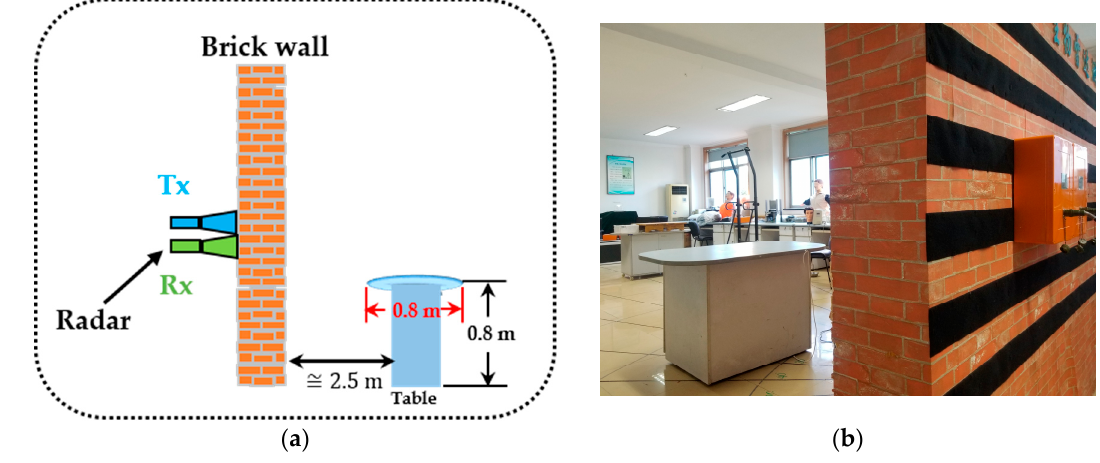
Figure 13. Photograph and geometry of no target signals acquisition experiment: ( a ) Sketch map of no